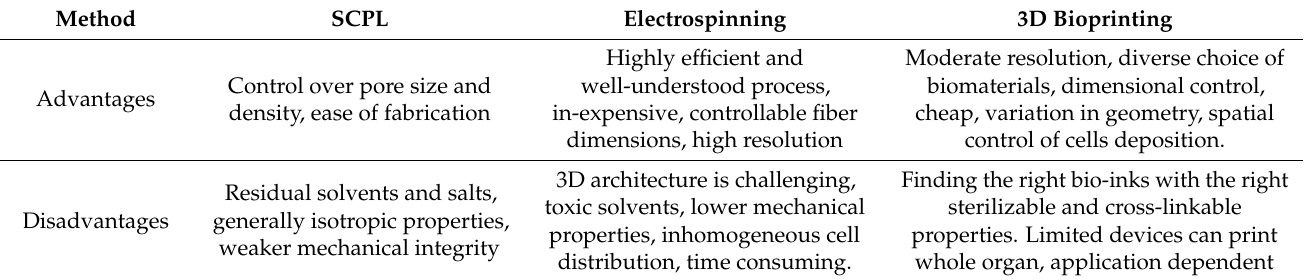
Table 2. The advantages and disadvantages of fabrication methods used in creating 3D